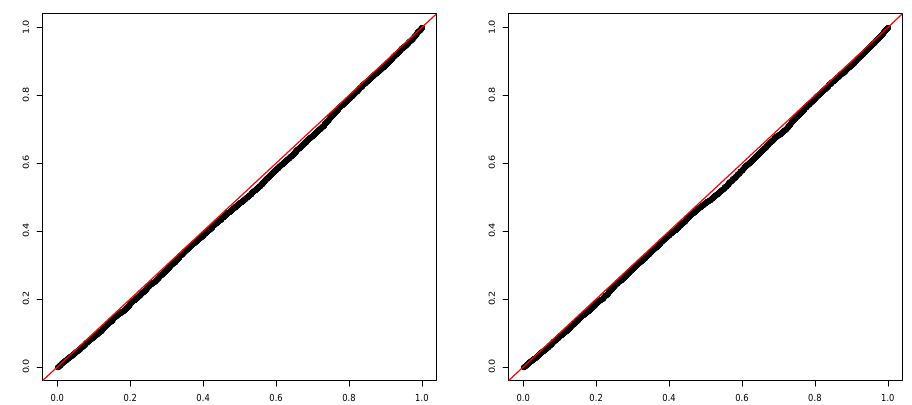
Figure 11. Comparison of asymptotic and bootstrap p -values under the null hypothesis and Poisson innovations: ( left panel ) semiparametric bootstrap; ( right panel ) parametric bootstrap. The red dashed line represents the 45-degree line.